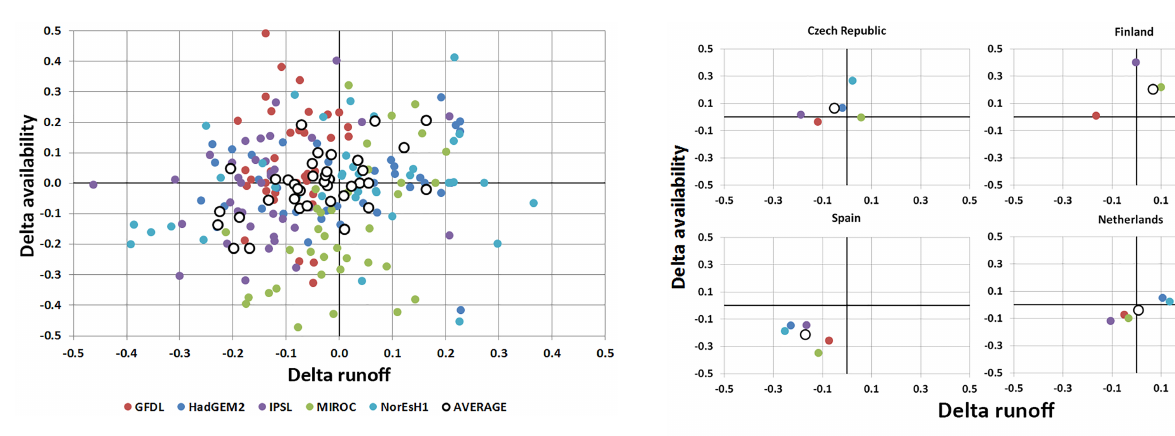
Figure 5. Country estimates of changes in average runoff and sur- face water availability in the long term period (2060–2099) with respect to the control period (1960–1999) under emission scenario RCP4.5. Results show the five GCM forcing models considered and the average value.